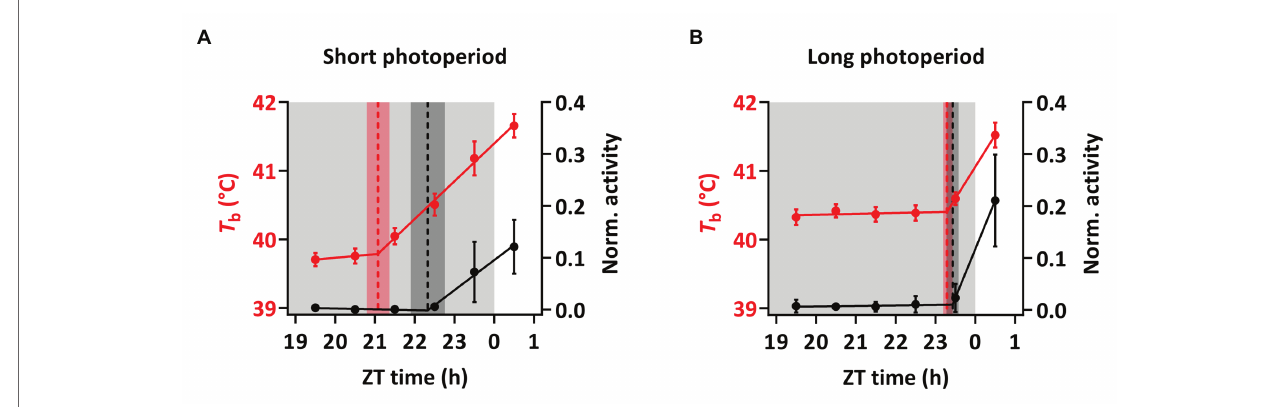
FIGURE 5 | Anticipatory rise in T b based on segmental regression breakpoints. Hourly means of T b (red) and activity (black) 5 h before and 1 h after the light-on signal, given in Zeitgeber time (ZT). (A) T b in birds under SP was rising 2 h 56 min before the light-on signal while activity rises 1 h 40 min before light-on. (B) In birds under LP T b increased 43 min before light-on, while activity rose 34 min before the light-on signal. The data correspond to the measurement in Figure 4 and Supplementary Figure S4 and are displayed as mean ± 95% CI. Dotted lines indicate segmented regression breaking points and the shading shows the corresponding SD. Light gray shadings indicate periods of